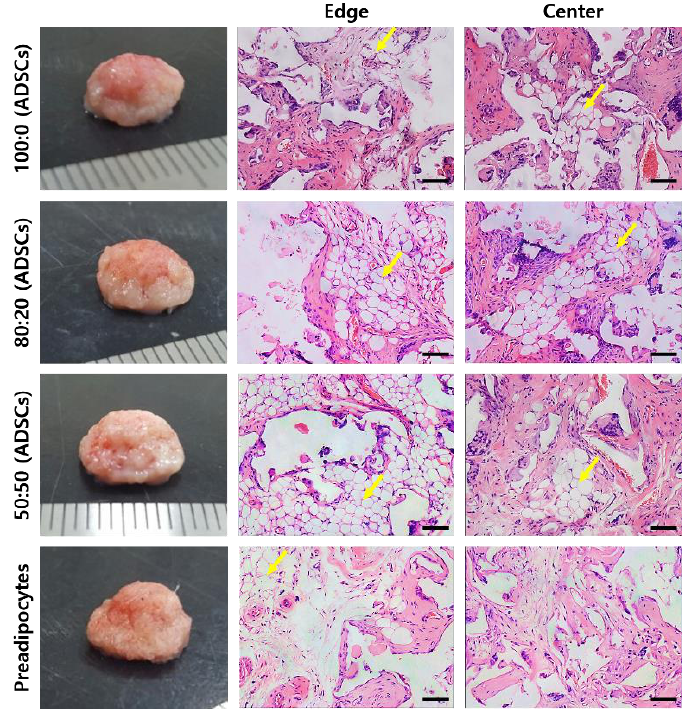
Figure 6. H&E staining for each group of the 12-week in vivo samples (yellow arrows: mature adipose tissue). Scale bar: 100 μm.